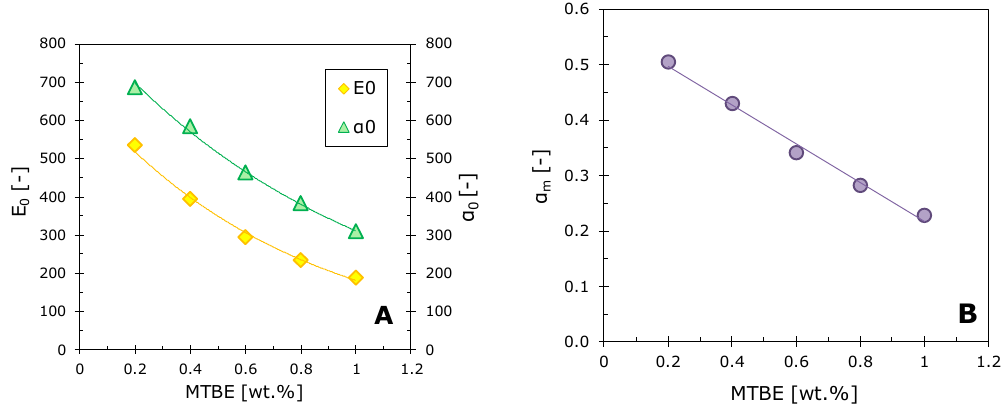
Figure 9. The dependence of the intrinsic enrichment factor E0 and the intrinsic separation factor α 0 ( A ) and the dependence of the membrane selectivity α m ( B ) on the MTBE concentration in the feed solution. T = 50 ◦